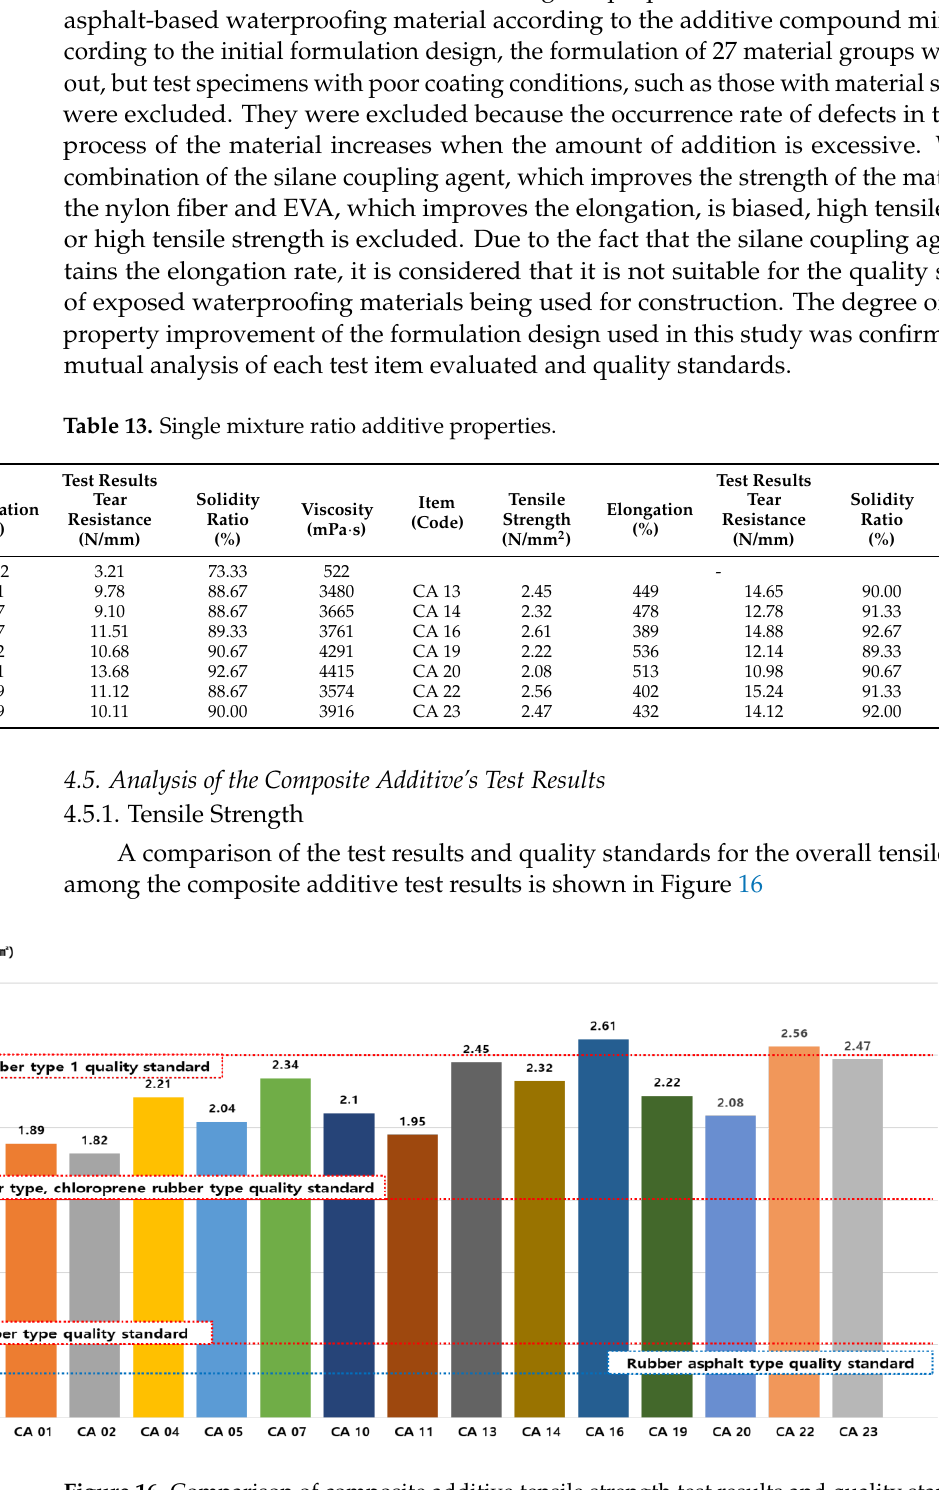
Figure 16. Comparison of composite additive tensile strength test results and quality standards.